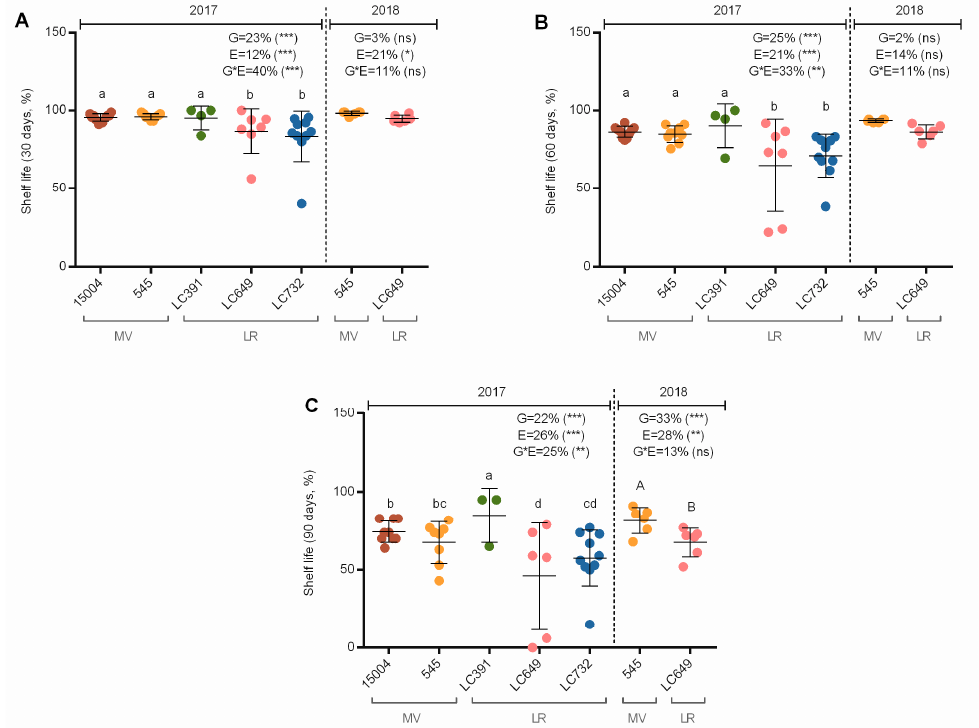
Figure 9. Differences between modern varieties (545, 15004) and landraces (LC391, LC649, LC732) for postharvest shelf- life at ( A ) 30, ( B ) 60, and ( C ) 90 days. Mean ± SEM calculated from 2017 (Exp7–Exp16) and 2018 trials (Exp1–Exp6). For each year, different letters (2017, lowercase; 2018, capital letters) indicate significant differences between genotypes (Student–Newman–Keuls, p < 0.05). G, E, and G*E percentages indicate the relative contributions of genotype, environment, and genotype-by-environment interaction, respectively, to the total observed phenotypic variation. Level of significance: * p < 0.05; ** p < 0.01; *** p < 0.001; ns, not significant ( p > 0.05).